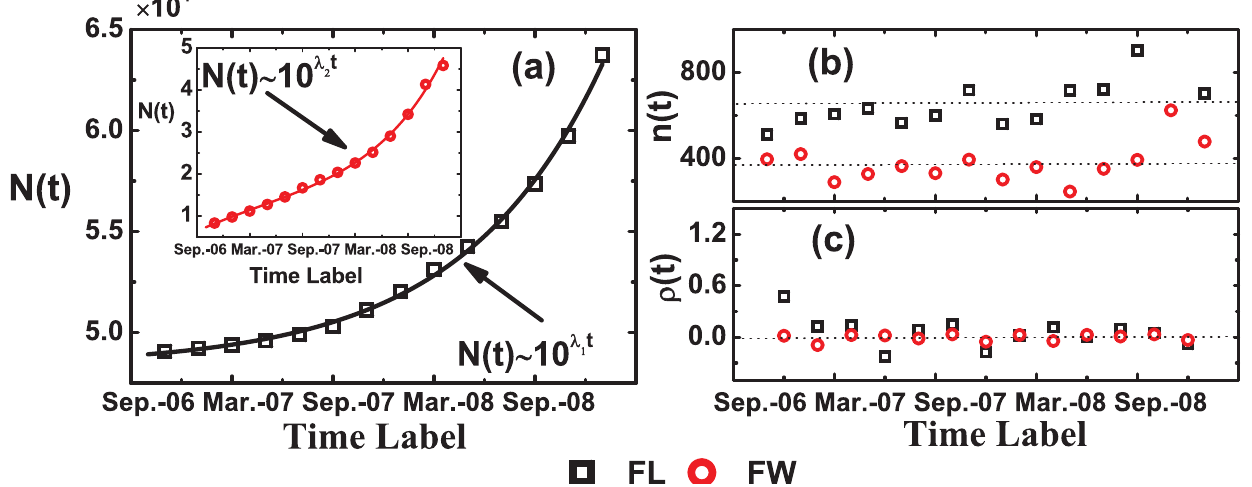
(t) (b), as well as p